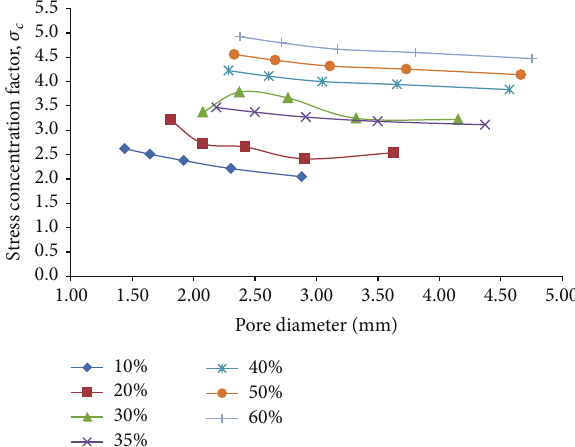
Figure9:Plotsdepictingvariationofthestressconcentrationfactor, 𝜎 𝑐 , as a function of pore diameter for different percentage of porosity for the case of compressive loading only using 3D porous FE cubic